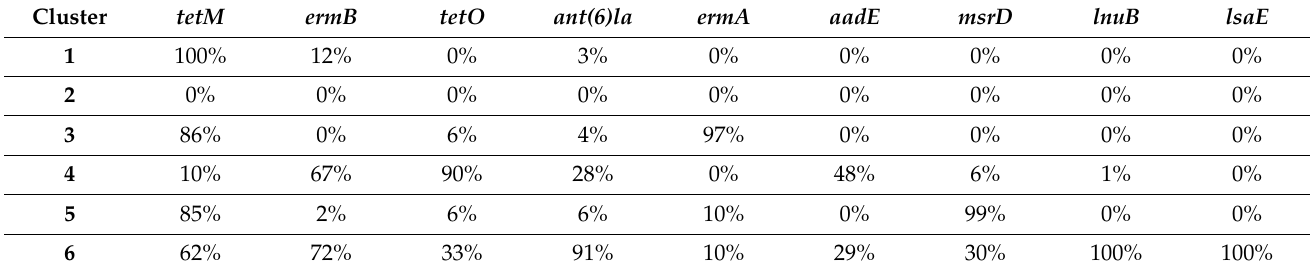
Table 6. Distribution of the most frequent isolated genes among the six identified clusters.